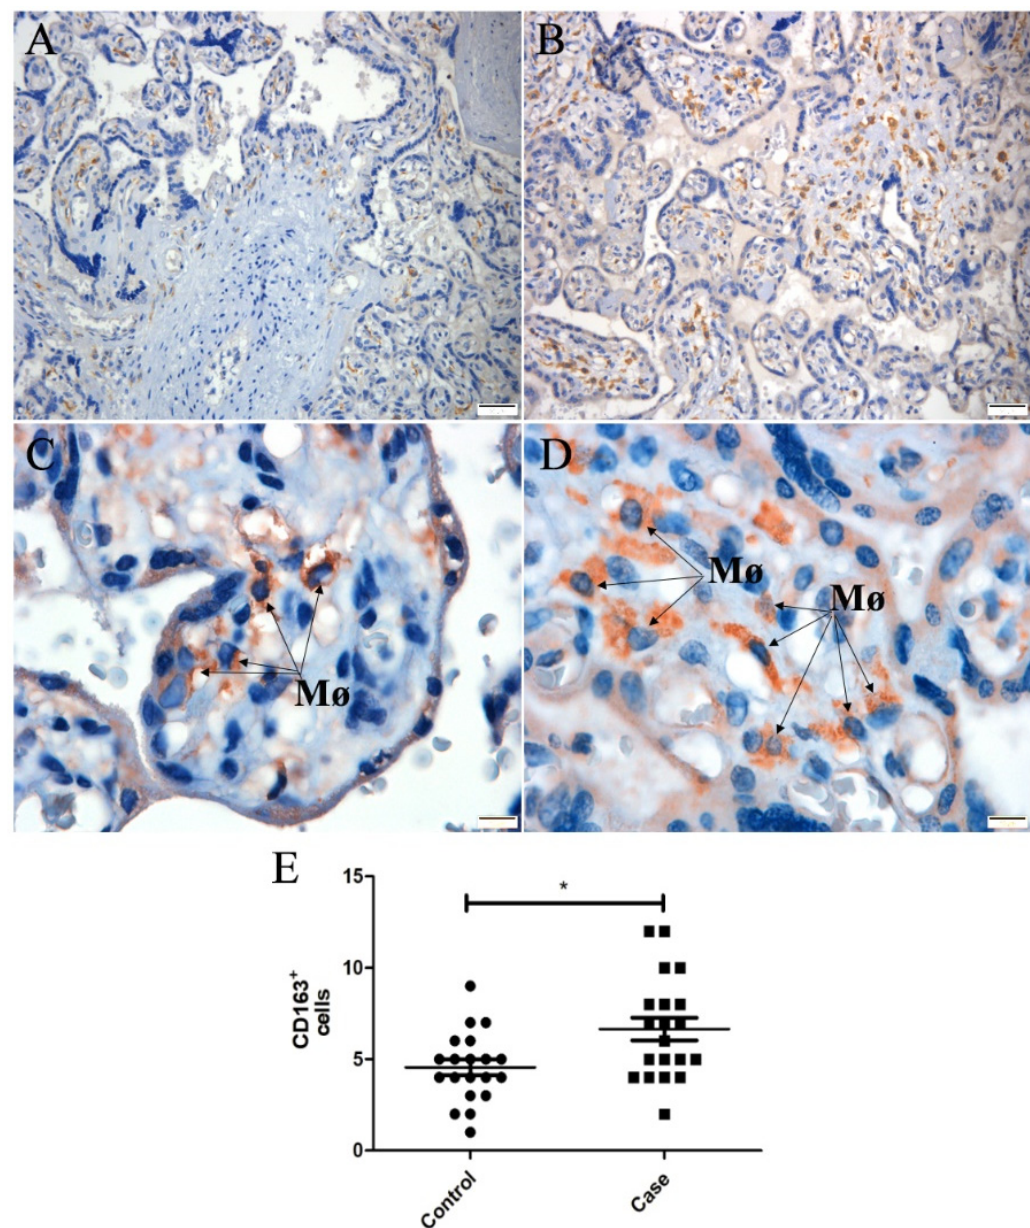
Figure 3. Tissue expression and quantification of CD163 + cells in the placenta. ( A , C ) Control tissue (uninfected placenta in lower and higher magnification, respectively; ( B , D ) CHIKV placenta in lower and higher magnification, respectively; ( E ) quantification of CD163 + , showing increased expression in the CHIKV-infected placenta compared to the control. The square (control) and the circle (infected placenta) represent each acquired image, and the number of positive cells is represented in y axis. * indicates statistically significant differences between groups (* p < 0.05).